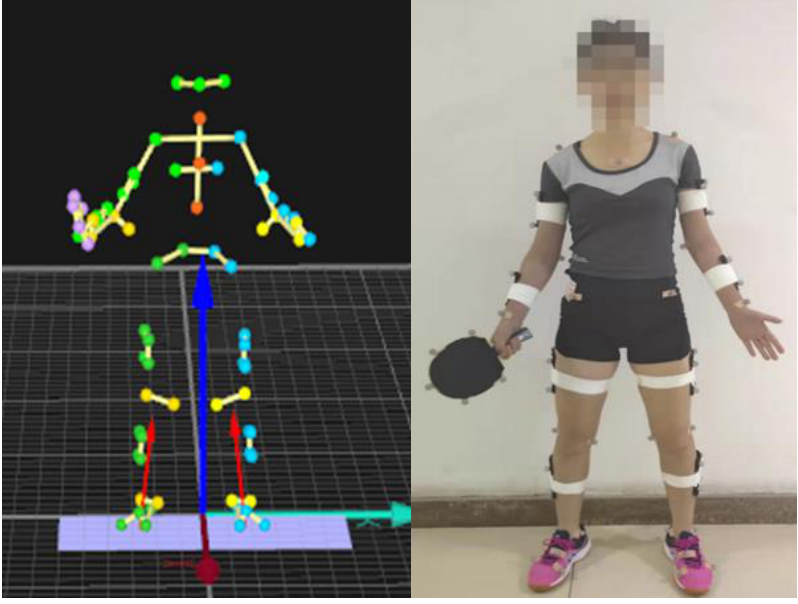
Figure 2. Marker placement adopted in the